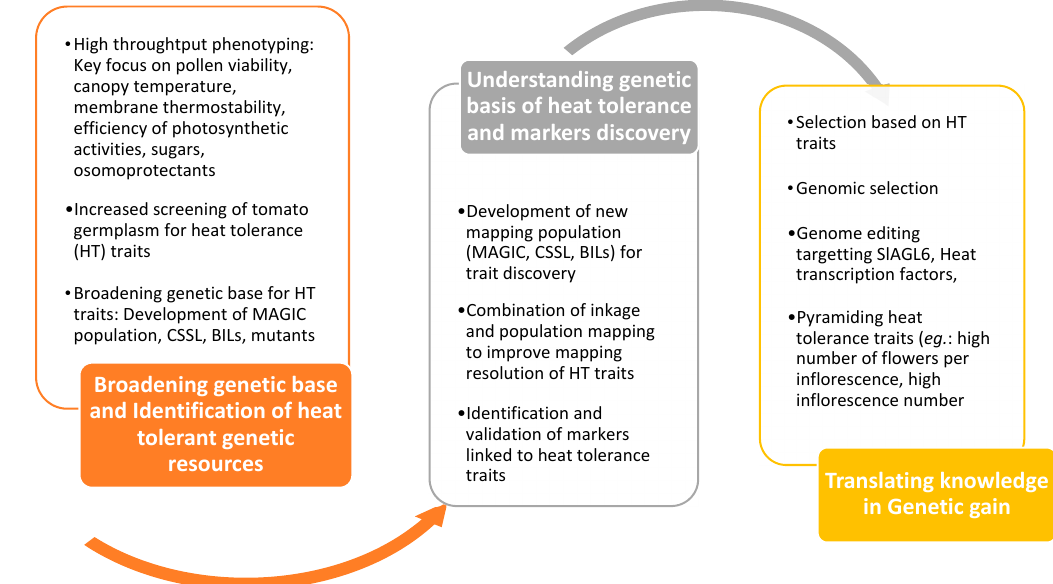
Figure 3. From discovery of heat tolerant genetic resources to genetic gain.